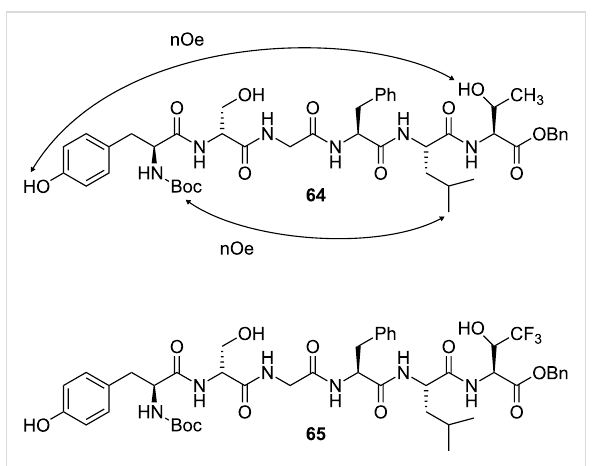
Figure 17: Enkephalin-related peptide 64 and the fluorinated analogue 65 . The electron-withdrawing trifluoromethyl group of 65 disrupts a key hydrogen bond, leading to a different conformation as determined by NOESY